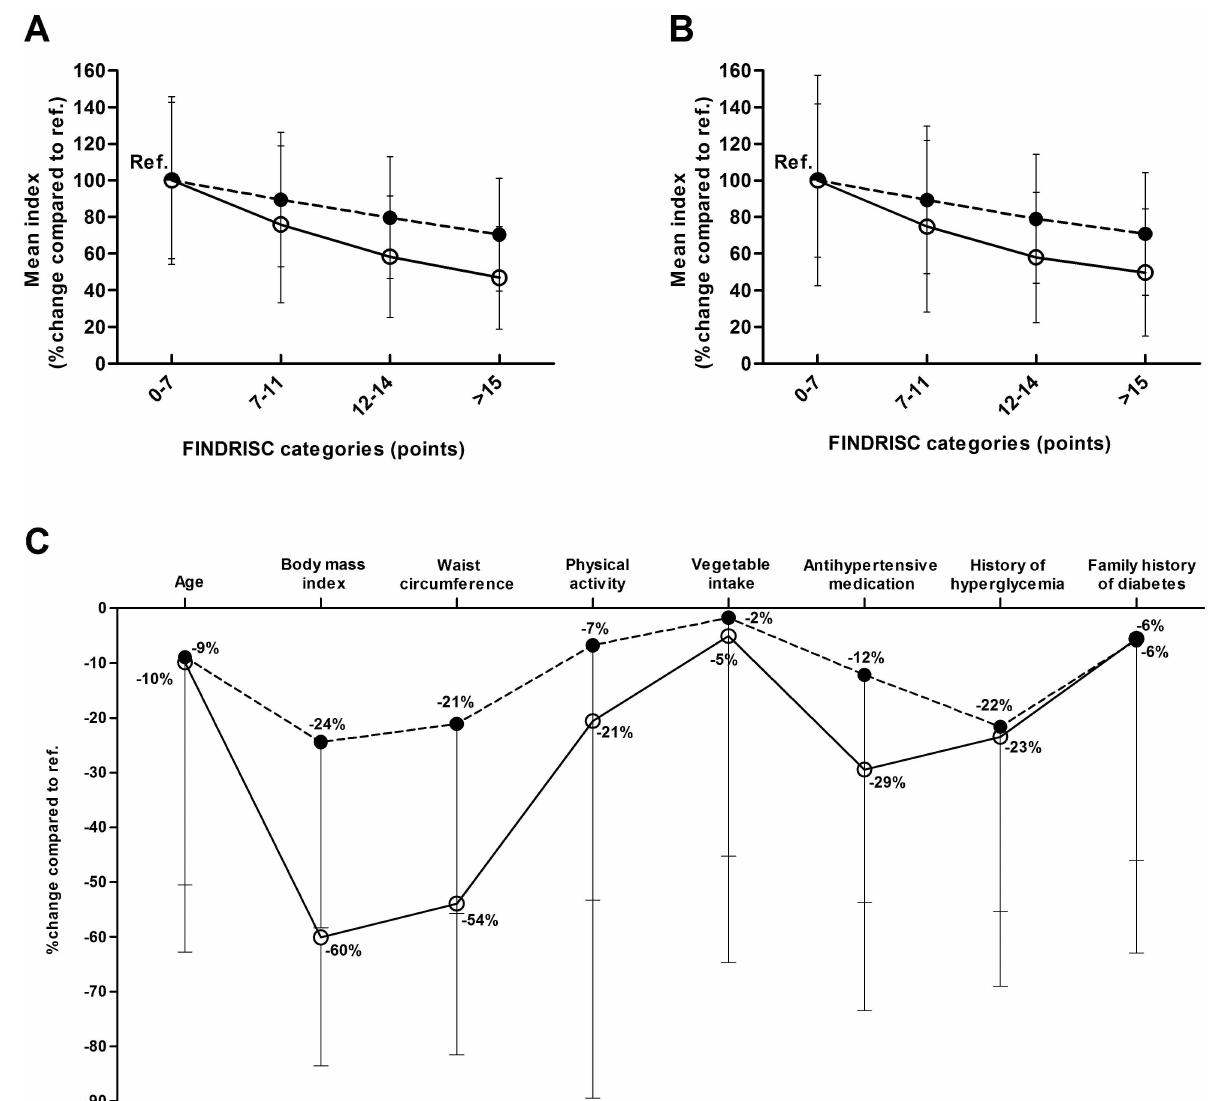
Fig 1. Percentage decreasesin insulin sensitivity (Matsuda ISI, open circles) and insulin secretion (Disposition index, filled circles, dashed lines) across the Finnish Diabetes Risk Score (FINDRISC) categories compared to the referencecategory ( < 7 points). (A) in the non-diabetic participantsof the METSIM baselinestudy, (B) in the participants of the METSIM 4.6-yearfollow-upstudy (participants without diabetesor with newly-diagnosed diabetes at the follow-upexamination) (C) in the subcategories of the eight components of the FINDRISC at baseline(referencecategoriesin C for each componentrespectivelyare as follows: age < 55years, BMI < 25 kg/m 2 , waist < 94cm, physicalactivity at least 30 min (cid:21) 2 times per week, vegetableintake every day, no antihypertensive medication, no history of hyperglycemia, no family history of diabetes). Data are means ± SD.